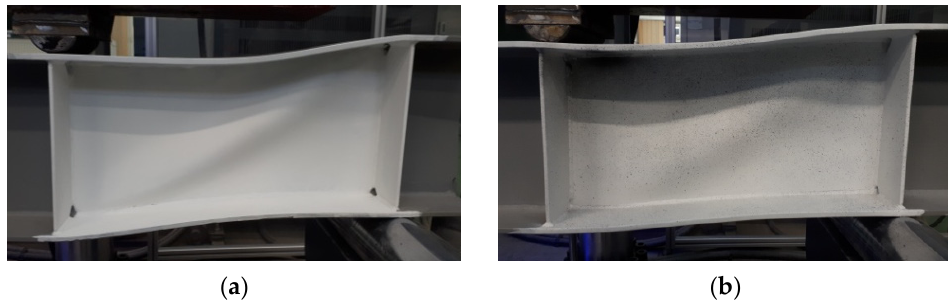
Figure 15. Failure forms of BP 250 beams: ( a ) 3 mm-thick web and ( b ) 5 mm-thick web.